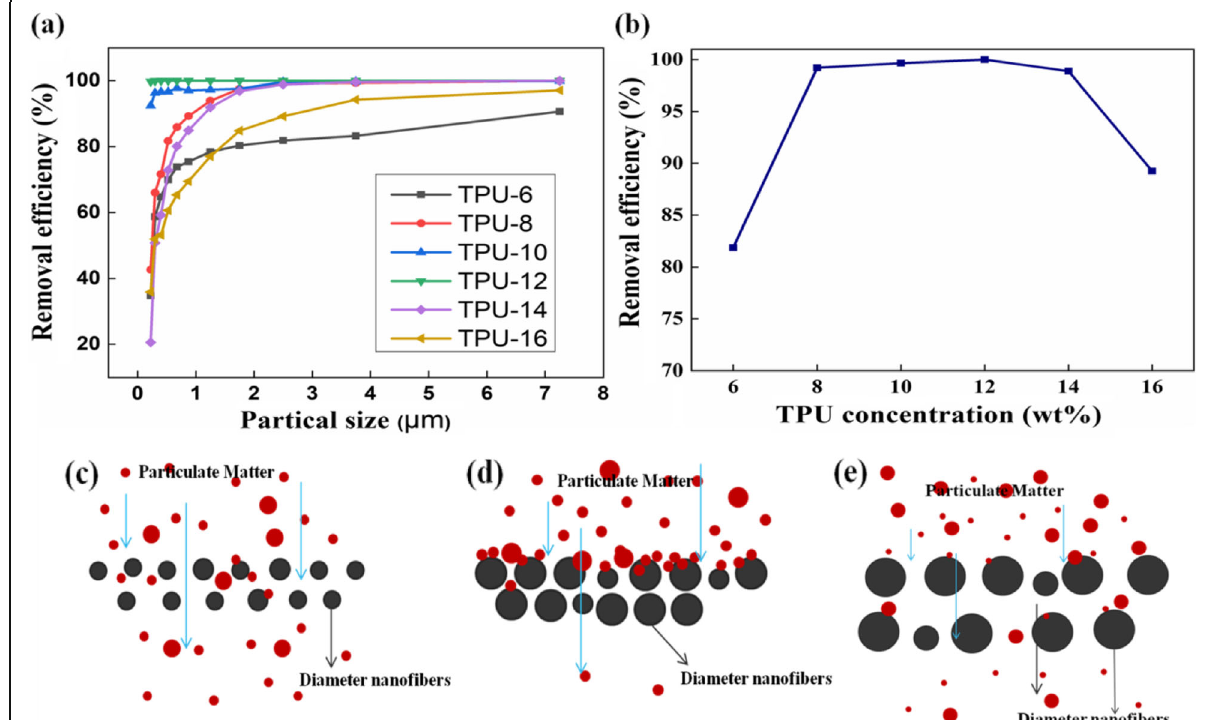
Fig. 4 Evaluation of filtration efficiency of TPU fiber membrane. a Remove efficiency of PM of different sizes with TPU concentrations of 6 wt%, 8 wt%, 10 wt%, 12 wt%, 14 wt%, and 16 wt%, respectively. b PM2.5 removal efficiency of different concentrations of TPU fiber membranes. c – e PM through different diameter fiber